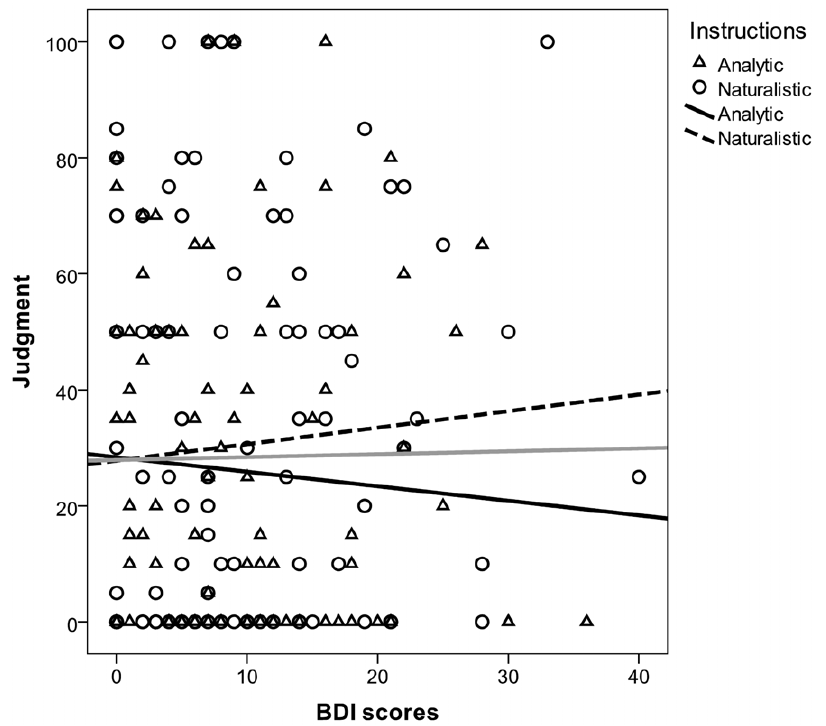
Figure 4. Scatterplot depicting judgments as a function of BDI scores in Study 2. Three regression lines are plotted: The shaded line shows the overall relation between BDI scores and judgments; the full black line and the dashed black line refer to the Analytic and Naturalistic groups, respectively. Note the flatness of the three slopes (in fact, no coefficient was significantly different from zero; see main text).